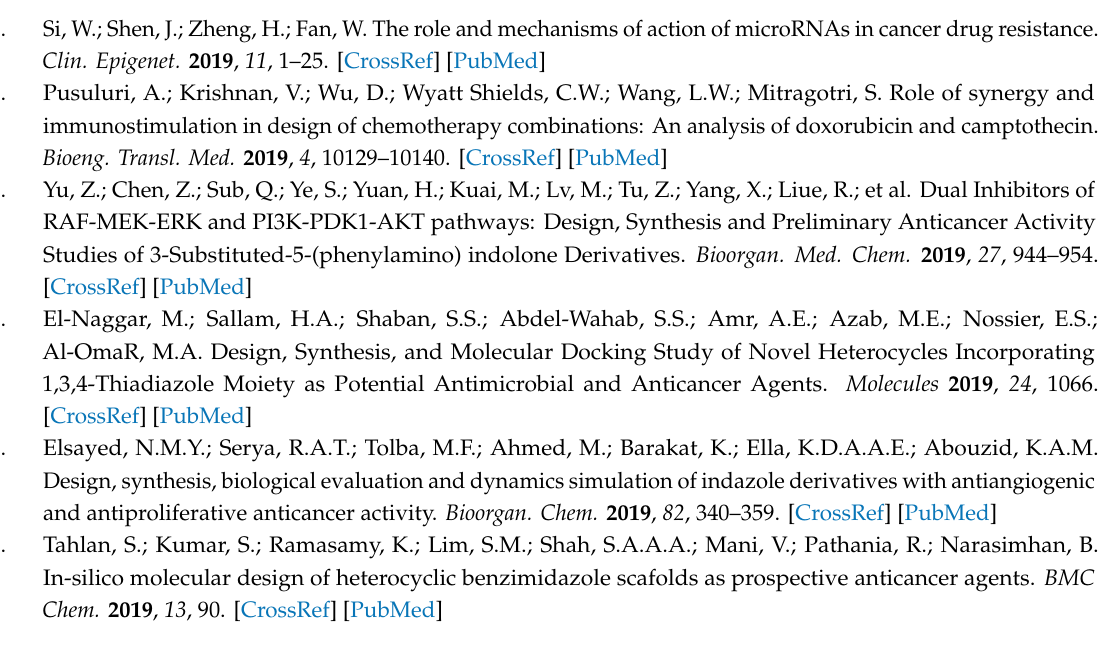
Figure S1: ESI-MS spectrum of compound 2 , Figure S2: ESI-MS spectrum of compound 3 , Figure S3: ESI-MS spectrum of compound 4 , Figure S4: ESI-MS spectrum of compound 5 , Figure S5: ESI-MS spectrum of compound 6 , Figure S6: ESI-MS spectrum of compound 7 , Figure S7: ESI-MS spectrum of compound 8 , Figure S8: ESI-MS spectrum of compound 9 , Figure S9: ESI-MS spectrum of compound 10 , Figure S10: ESI-MS spectrum of compound 11 , Figure S11: 1 H NMR spectrum of compound 2 , Figure S11: 1 H NMR spectrum of compound 2 , Figure S12: 1 H NMR spectrum of compound 3 , Figure S13: 1 H NMR spectrum of compound 4 , Figure S14: 1 H NMR spectrum of compound 5 , Figure S15: 1 H NMR spectrum of compound 6 , Figure S16: 1 H NMR spectrum of compound 7 , Figure S17: 1 H NMR spectrum of compound 8 , Figure S18: 1 H NMR spectrum of compound 9 , Figure S19: 1 H NMR spectrum of compound 10 , Figure S20: 1 H NMR spectrum of compound 11 , Figure S21: 13 C NMR spectrum of compound 2 , Figure S22: 13 C NMR spectrum of compound 3 , Figure S23: 13 C NMR spectrum of compound 4 , Figure S24: 13 C NMR spectrum of compound 5 , Figure S25: 13 C NMR spectrum of compound 6 , Figure S26: 13 C NMR spectrum of compound 7 , Figure S27: 13 C NMR spectrum of compound 8 , Figure S28: 13 C NMR spectrum of compound 9 , Figure S29: 13 C NMR spectrum of compound 10 , Figure S30: 13 C NMR spectrum of compound 11 , Figure S31: 1 H- 13 C NMR spectrum of compound 2 , Figure S32: 1 H- 13 C NMR spectrum of compound 3 , Figure S33: 1 H- 13 C NMR spectrum of compound 4 , Figure S34: 1 H- 13 C NMR spectrum of compound 5 , Figure S35: 1 H- 13 C NMR spectrum of compound 6 , Figure S36: 1 H- 13 C NMR spectrum of compound 7 , Figure S37: 1 H- 13 C NMR spectrum of compound 8 , Figure S38: 1 H- 13 C NMR spectrum of compound 9 , Figure S39: 1 H- 13 C NMR spectrum of compound 10 , Figure S40: 1 H- 13 C NMR spectrum of compound 11